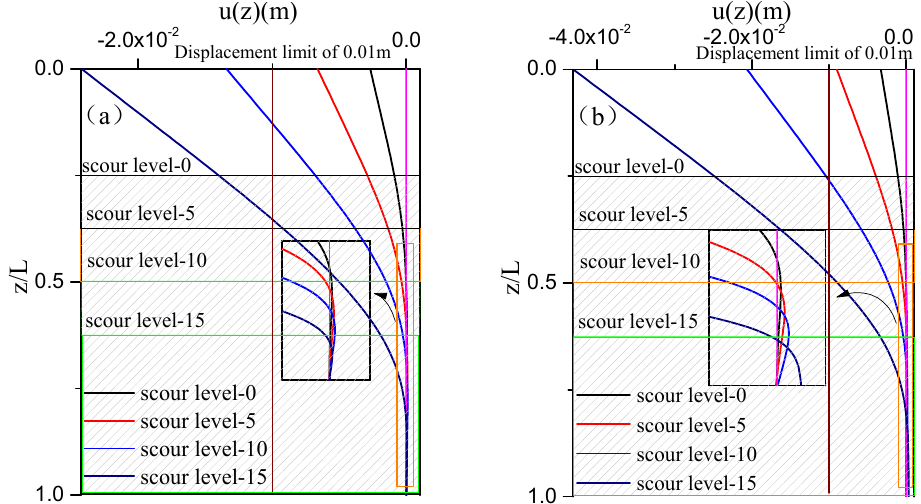
Figure 6. Effect of the scour degree on the dynamic response of the single pile in layered foundation: ( a ) Free-fixed pile; ( b ) Free-free pile.